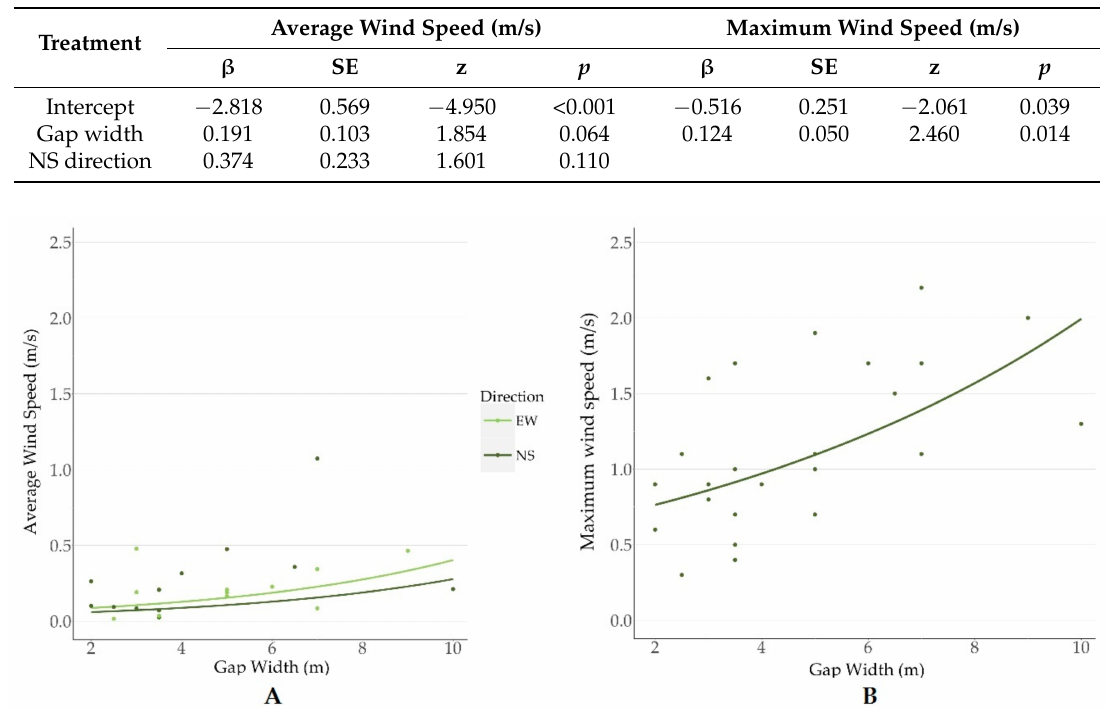
Figure 5. Scatterplots and GLMM model predictions of ( A ) average windspeed (m/s) by gap (line) width for either east-to-west (EW) or north-to-south (NS) orientated seismic lines; and ( B ) maximum windspeed by gap